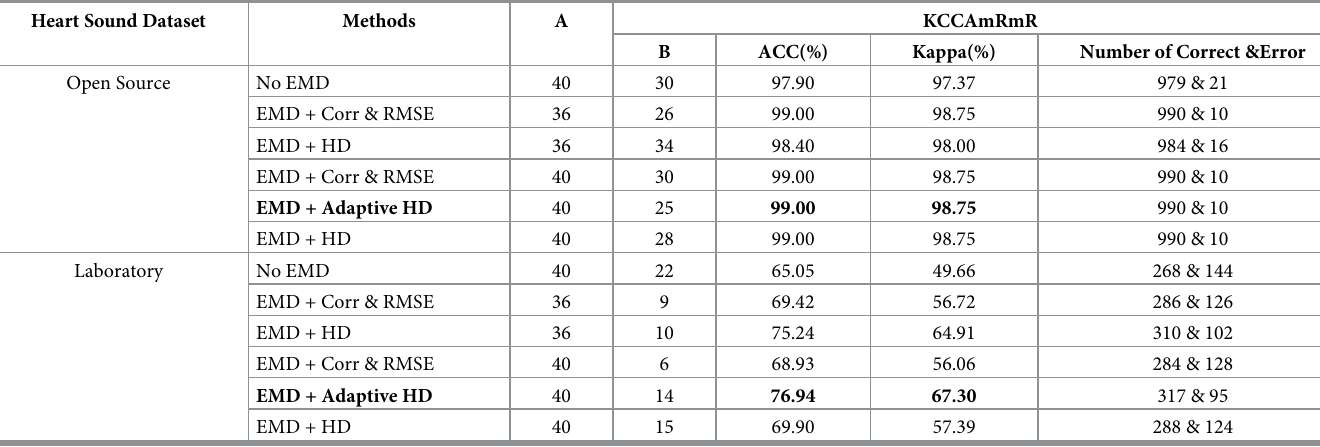
Table 5. Comparison of accuracy and feature dimension under different methods based on KCCAmRMR. Heart Sound